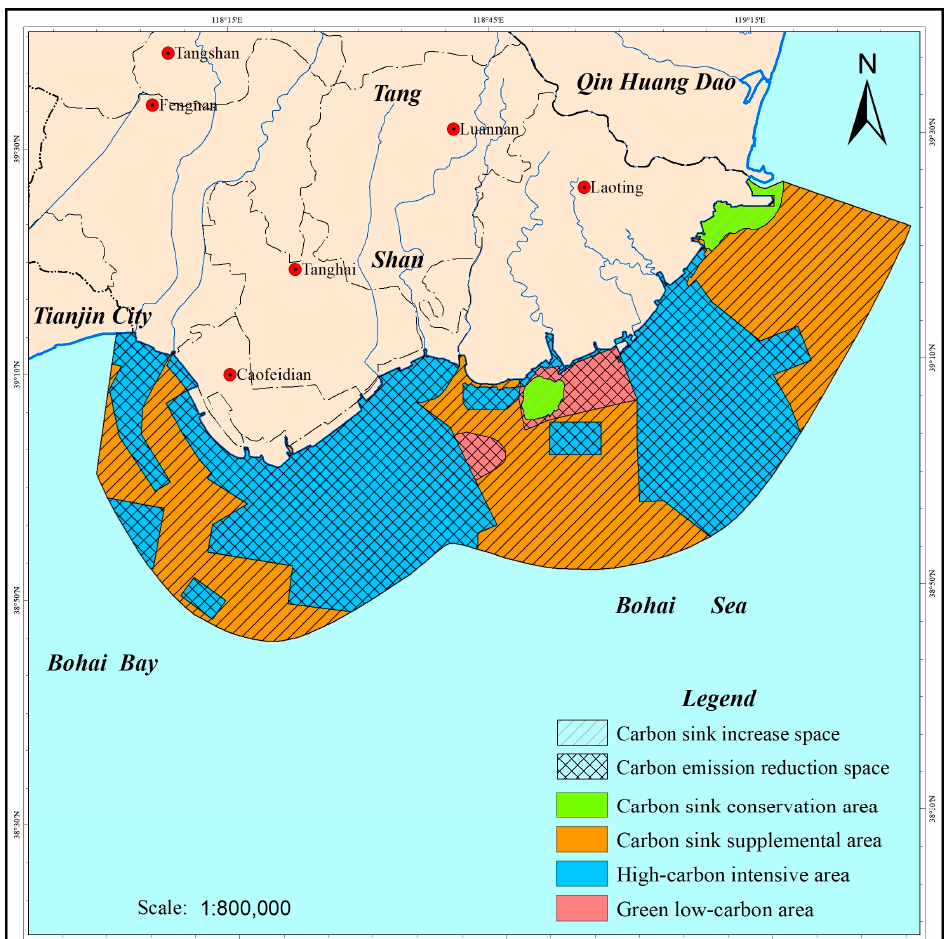
Figure 2. The “Two Spaces and Four Carbon Areas” marine spatial pattern of Tangshan, Hebei,